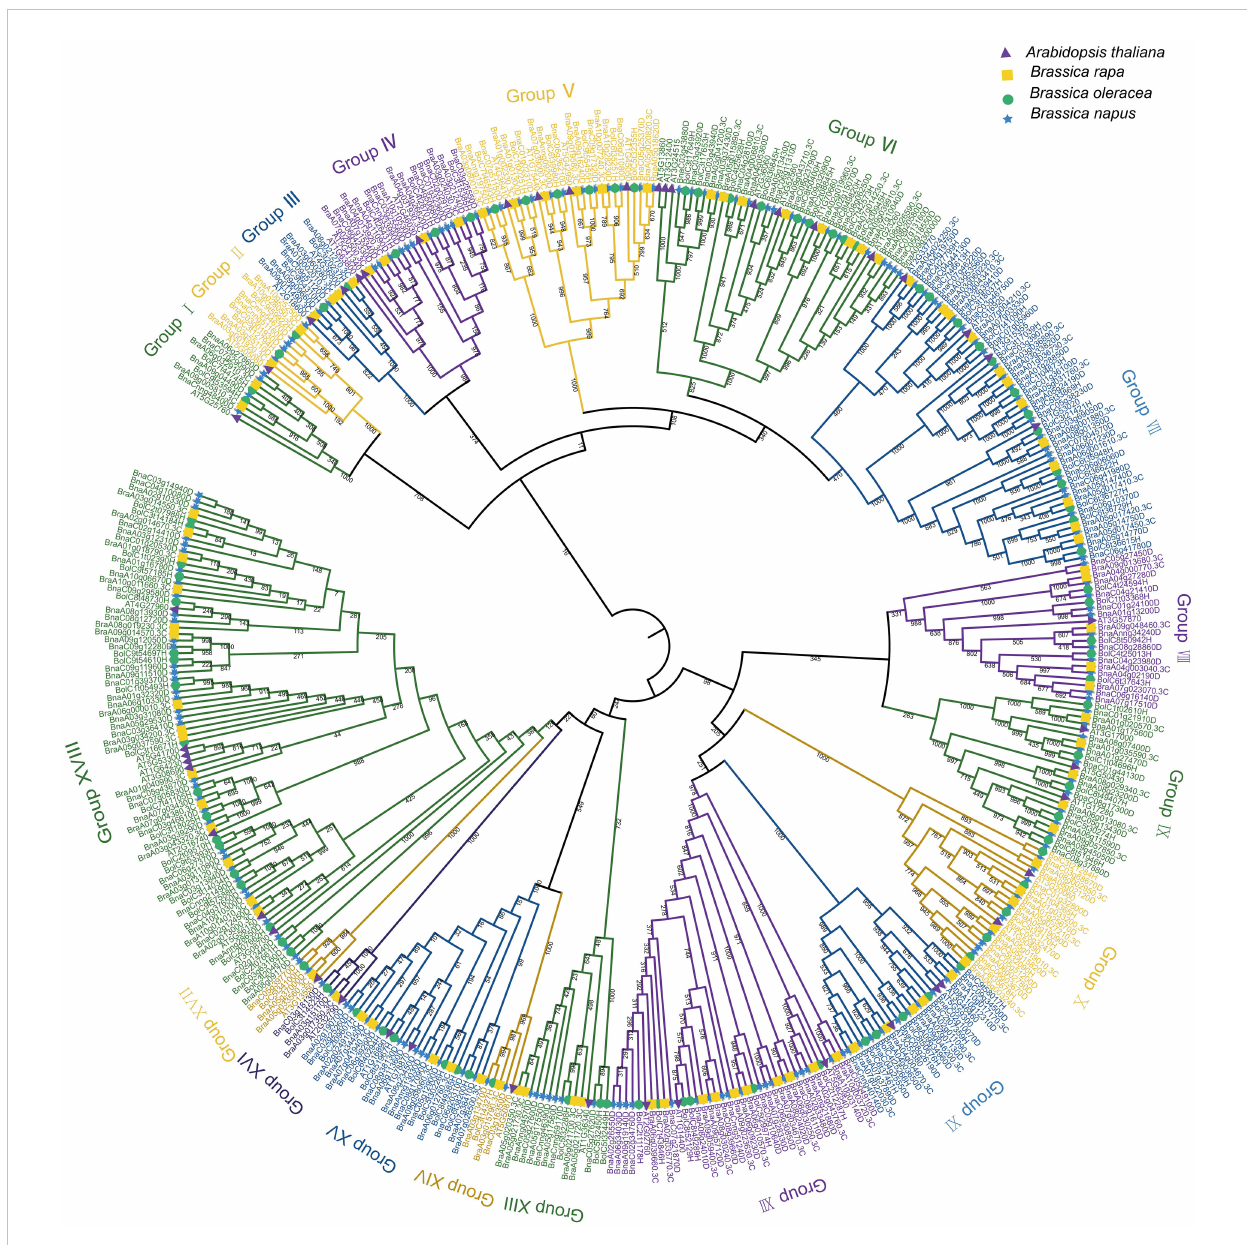
FIGURE 2 The phylogenetic relationship of UBC genes among A. thaliana , B. rapa , B. oleracea and B. napus . The construction of a phylogenetic tree using the UBC gene family among A. thaliana , B. rapa , B. oleracea , and B. napus . MEGA7.0 generated the phylogenetic tree topology using the neighbor- joining method with 1,000 bootstrap replicates. The members belonged to the same subgroup according to the node and branch they located and the characteristic of the tree. The different subgrouops were depicted in various